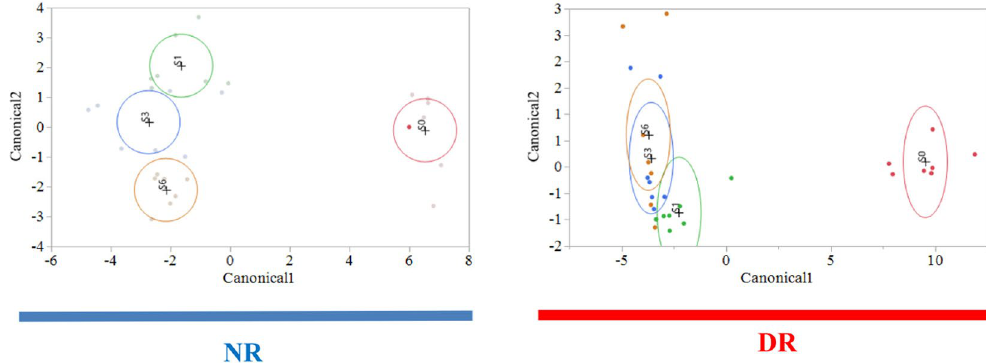
Figure 5. Discriminant analyses of fecal samples based on RATC function of microbiota for each treatment group by sampling week. Differences in in RATC profiles for each sampling week (pre-treatment, S0 = red dots; week 1, S1 = green dots; week 3, S3 = blue dots; week 6, S6 = orange dots) are illustrated by Canonicals 1 and 2. A circle indicates the 95% confidence region to contain the true mean of the group, and a plus symbol indicates the center (centroid) of each group.